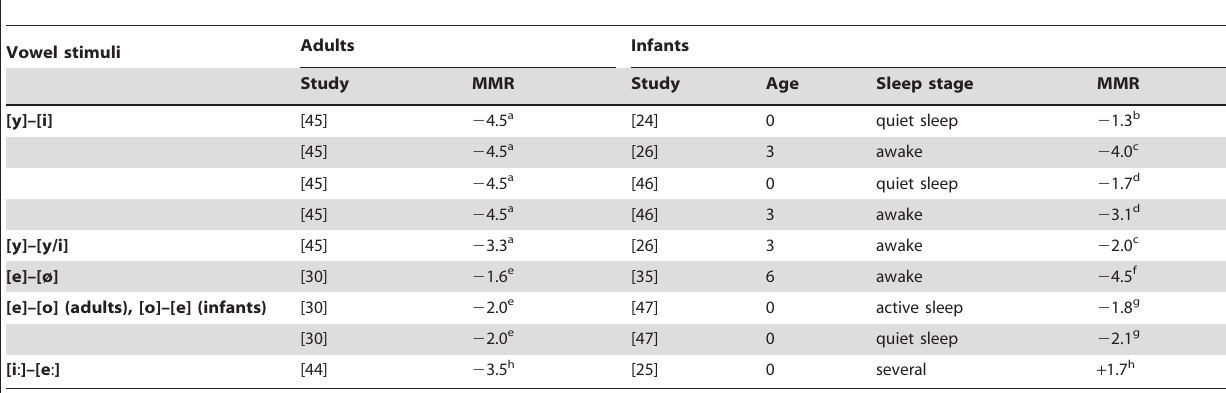
Table 1. Adult and infant studies in which MMRs to the same vowel pairs differing in quality ([standard]–[deviant]) were recorded.